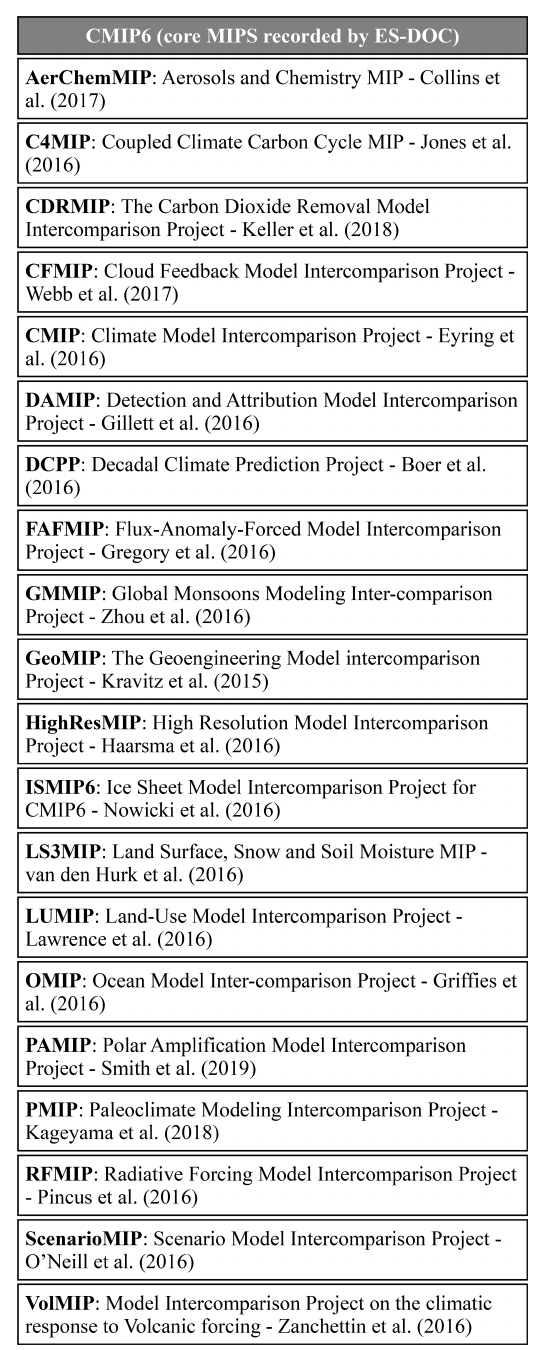
Table 4. The modelling CMIP6 experiments as introduced in Eyring et al. (2016). This list does not include CORDEX or the diagnostic MIPs, which are not currently included in the ES-DOC MIP docu- mentation.